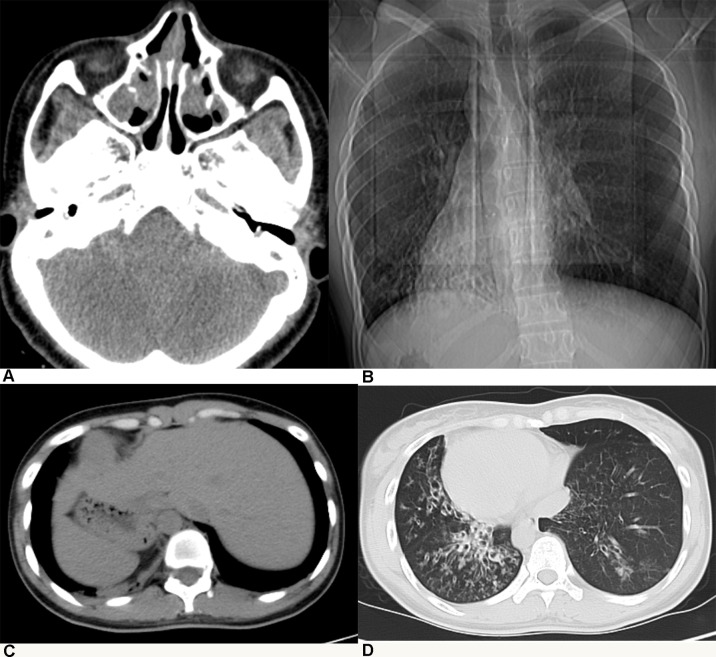
Patients with Kartagener syndrome diagnosed by radiological examination: (A) chronic sinusitis, (B, C) situs inversus, and (D) diffuse bronchiectasis.